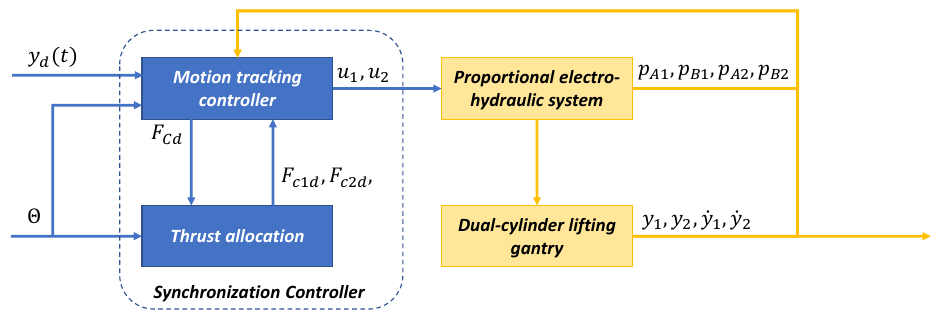
Figure 4. Synchronization controller